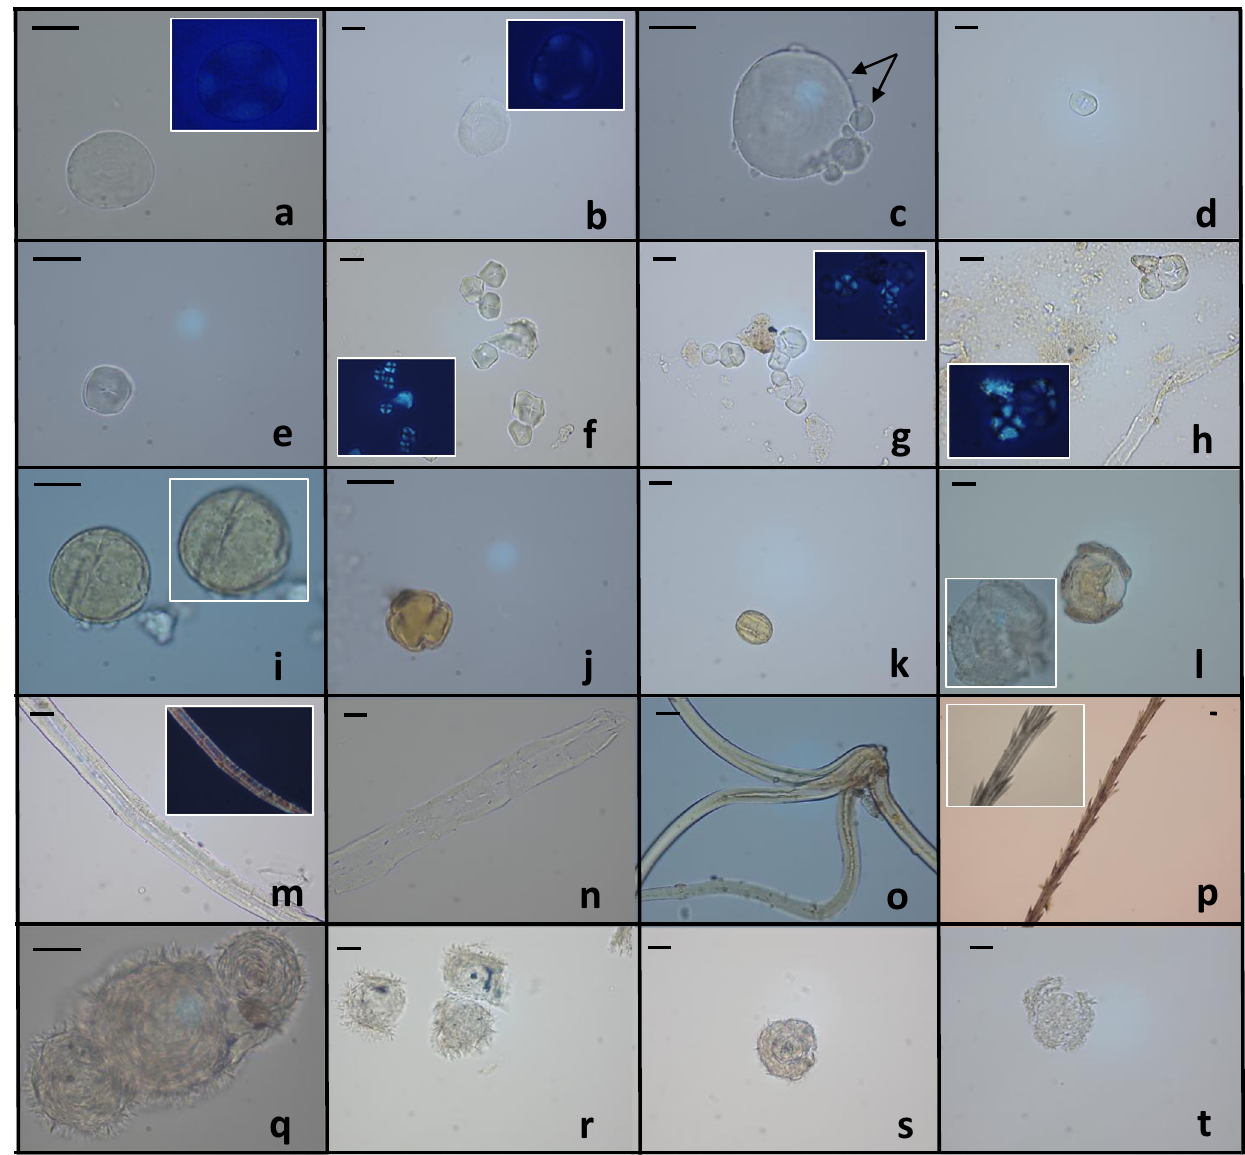
Fig. 2 Ancient microremains from human calculi. Representative images captured by optic microscopy were shown. a , b Triticeae starches. c Aggregate of Triticeae starch granules, the arrows indicate the co-presence of large and small starches. d , e Panicoideae starches. f Aggregates of Panicoideae starch granules emerging from undissolved dental calculus. g , h Panicoideae starch granules aggregates, adhering fl ecks of calculus can also be seen. i Fagaceae, Fagus pollen. j , k Quercus deciduous pollen. l Pinaceae pollen, in the white box another focus of corpus and sacci is reported. m , n Plant fi bres. o Stellate trichome. p Cichorieae/Astereae fruit fragment. q – t Unknown microparticles. Subpanels with dark background represent polarised images. The scale bar indicates 15 µ